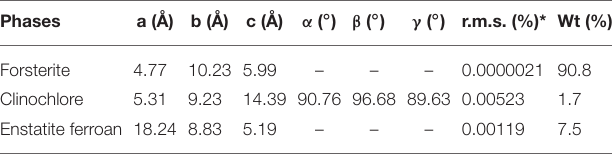
TABLE 1 | Phase composition and structural parameters of Olivine in the as-received state. Phases